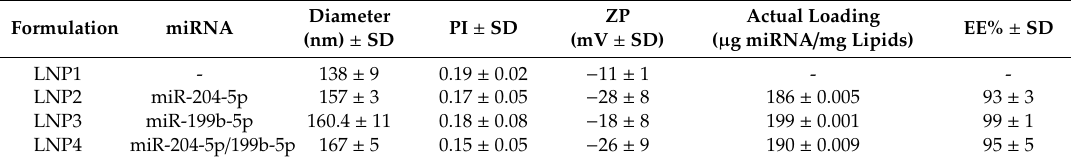
Table 1. Characteristics of LNP blank (LNP1) or encapsulating miRNA (LNP1, LNP2 and LNP3). For each formulation, size, polydispersity index (PI), zeta potential (ZP), actual loading and